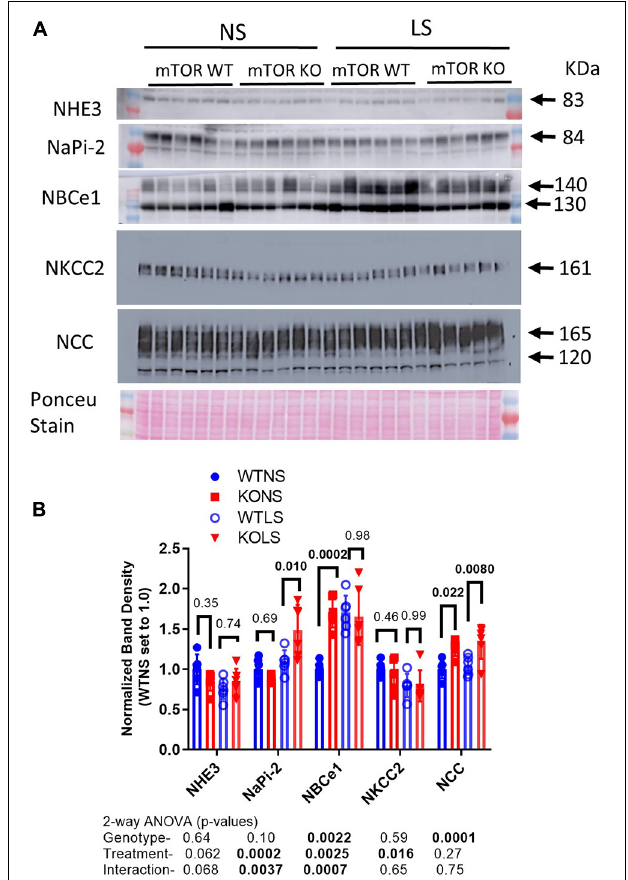
FIGURE 8 | Abundances of non-collecting-duct sodium reabsorptive proteins. Western blots of kidney (A) cortex homogenates from NS and LS diet fed male WT and KO mice were probed with antibodies against candidate proteins. (B) Band density (mean ± sem) summary ( n = 6 mice/treatment/genotype) and two-way ANOVA p-values for major bands. NHE3, sodium hydrogen exchanger, type 3; NaPi-2, sodium phosphate cotransporter, type 2; NBCe1, electrogenic sodium bicarbonate cotransporter, type 1; NKCC2, bumetanide-sensitive sodium potassium 2 chloride cotransporter, type 2; NCC, thiazide-sensitive sodium chloride cotransporter. KO mice had increased protein levels of NaPi-2 under LS diet, NBCe1 under NS diet, and NCC under both diets relative to